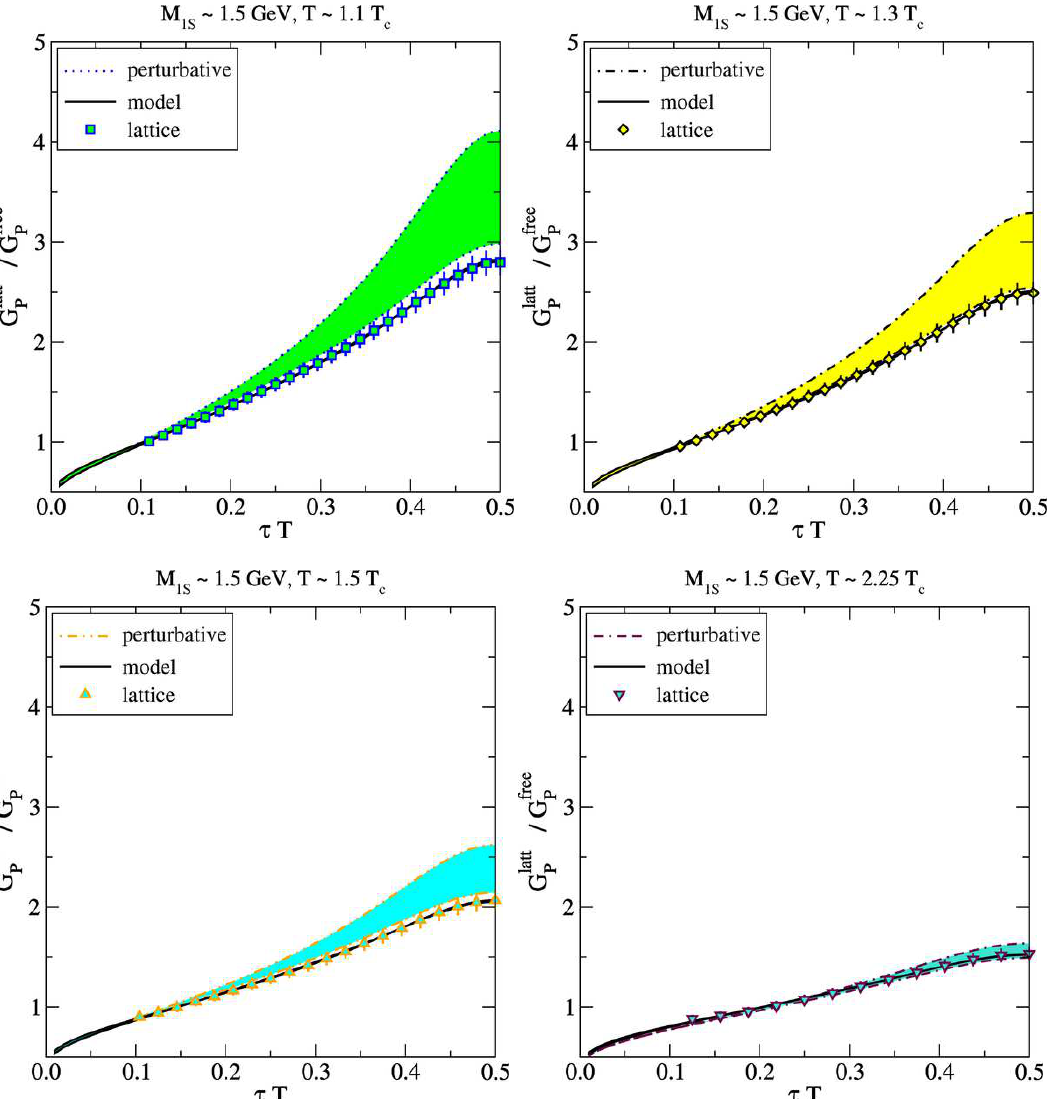
Figure 6 . Imaginary-time correlators corresponding to spectral functions modelled according to eq. (6.1) (narrow bands delineated by solid curves), compared with resummed perturbative pre- dictions from figure 4(left) (broad bands) and lattice data from figure 4(right) (open